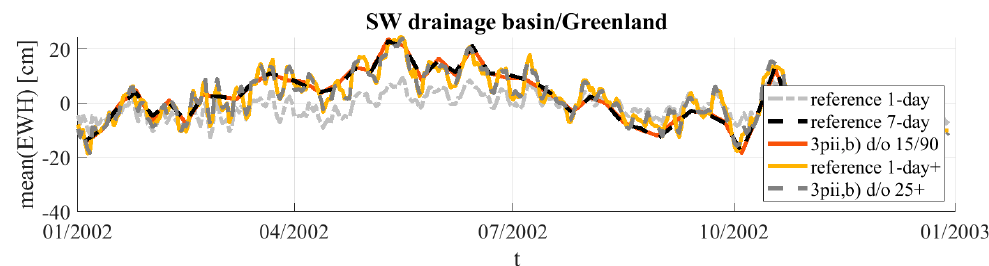
Figure 14. Time series in EWH (cm) for SW Greenland ice drainage basin based on Scenario 3pii,b comparing daily solutions (d/o 25) plus three-day solution (indicated by the “+”) up to 50 to the signal content of the seven-day solution up to d/o 50 of scenario 3pii,b for one year. The reference solution of the former daily solution is visualized in a light grey for comparison.